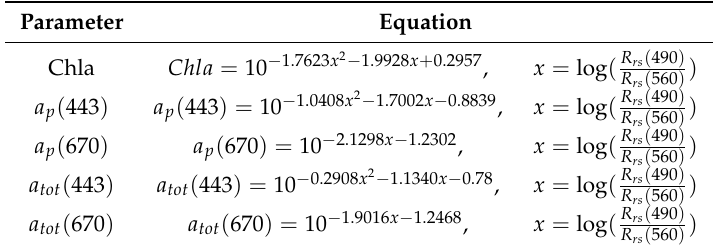
Table 3. Proposed empirical second-order polynomial formulas formulations for retrieving Chla , a p ( 443 ) , a tot ( 443 ) and and linear formulas for retrieving a p ( 670 ) and a tot ( 670 ) from spectral reflectance ratios adjusted to OLCI (Sentinel-3)